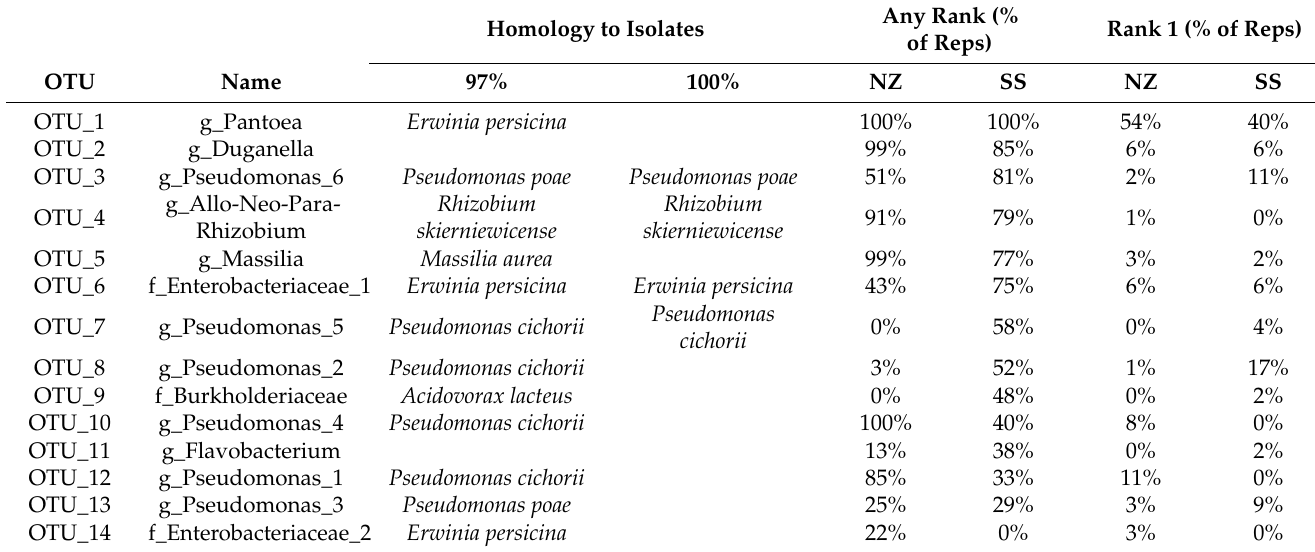
Table 3. Mapping of the 14 Rank 1 OTUs against isolates obtained from Lolium perenne . Homology to Isolates